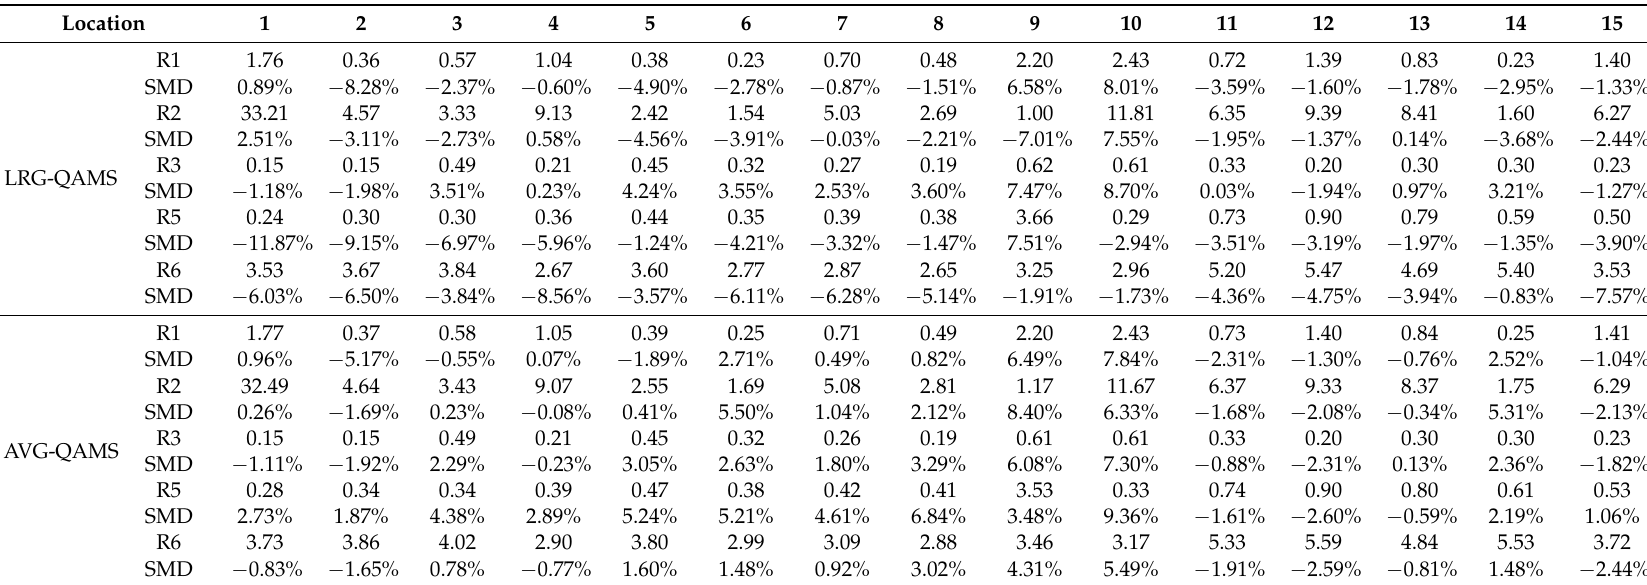
Table 7. The content of the marker components detected at 260 nm using both LRG-QAMS and AVG-QAMS method for data processing (mg/g).